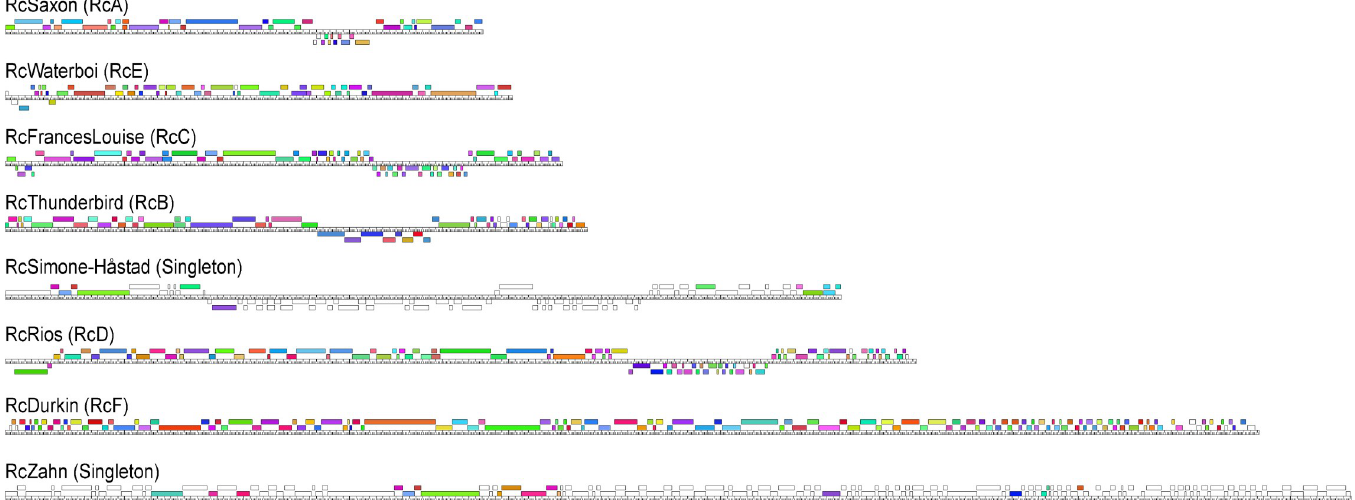
Fig 3. Gene content phamerator maps of the longest genomes for each cluster and the newly discovered singletons RcSimone-H å stad and RcZahn. Proposed genes transcribed from left to right are presented above the central graduated line while those transcribed in the opposite direction are found below the line. Boxes filled in with color represent genes that are shared by at least one other phage in the collection. Those without color represent orphams, or predicted genes that do not have any closely related homologues in this collection. The scale is the same for all genomes presented and they are ordered by length from shortest (RcSaxon, 36,081 bp) to longest (RcZahn, 101,599